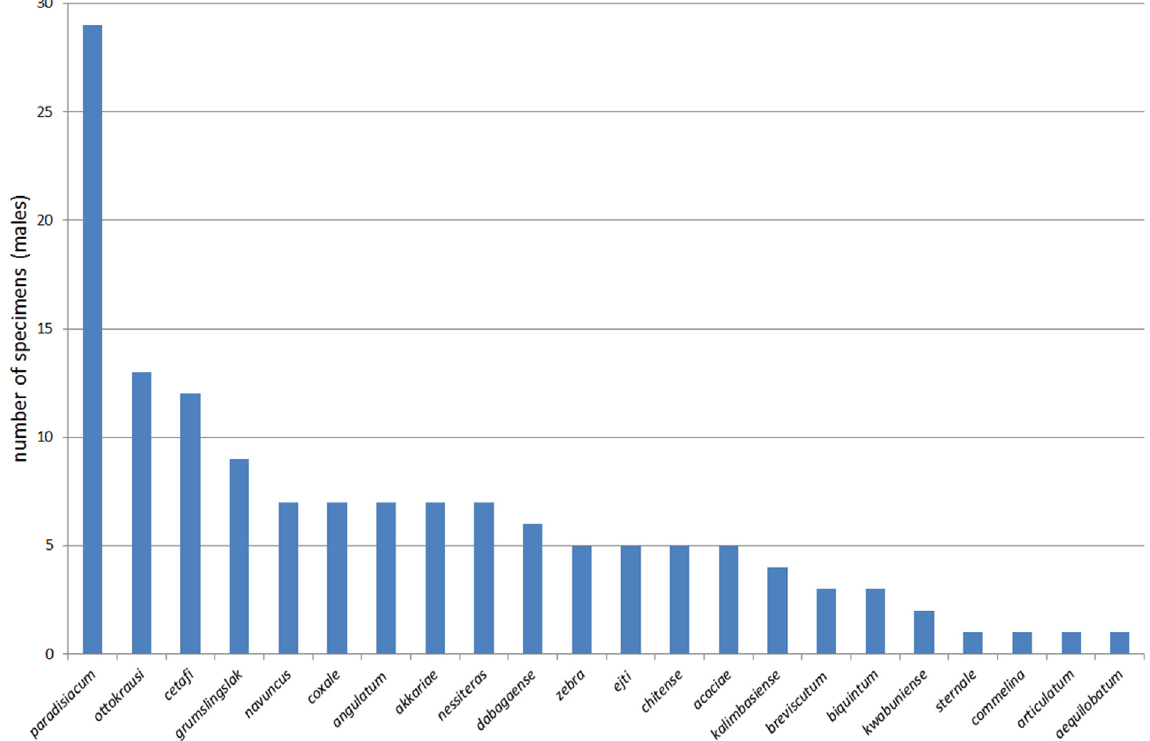
Fig. 41. The number of studied specimens (♂♂) per species of Udzungwan s. str. Eviulisoma Silvestri,